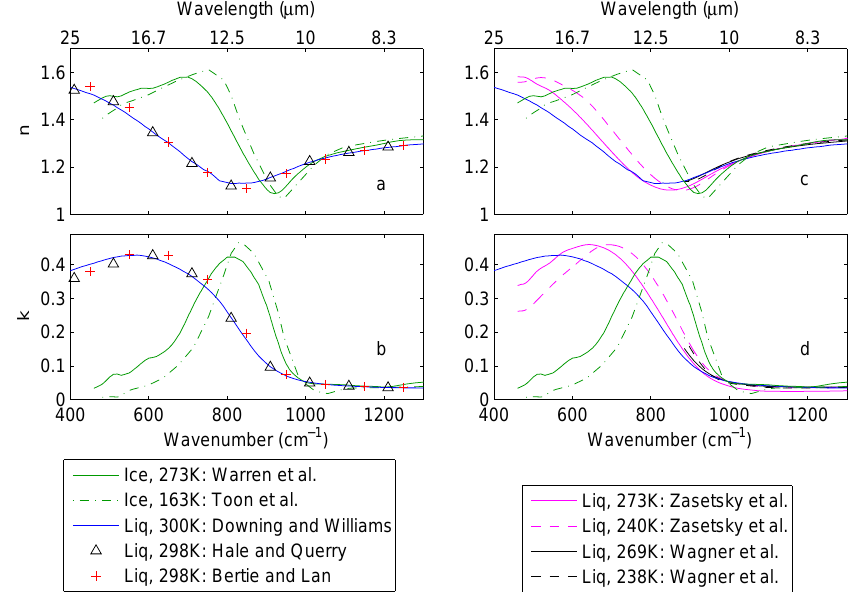
Fig. 1. Measurements of the complex refractive index (CRI) of ice and liquid water. Top panels show the real parts of the CRI ( n : a and c ), while bottom panels show the imaginary parts ( k : b and d ). The left panels show the CRI of liquid water for temperatures of 298K and above (made prior to 1996) while the right panels also include liquid water CRI at temperatures of 273K and below (made in